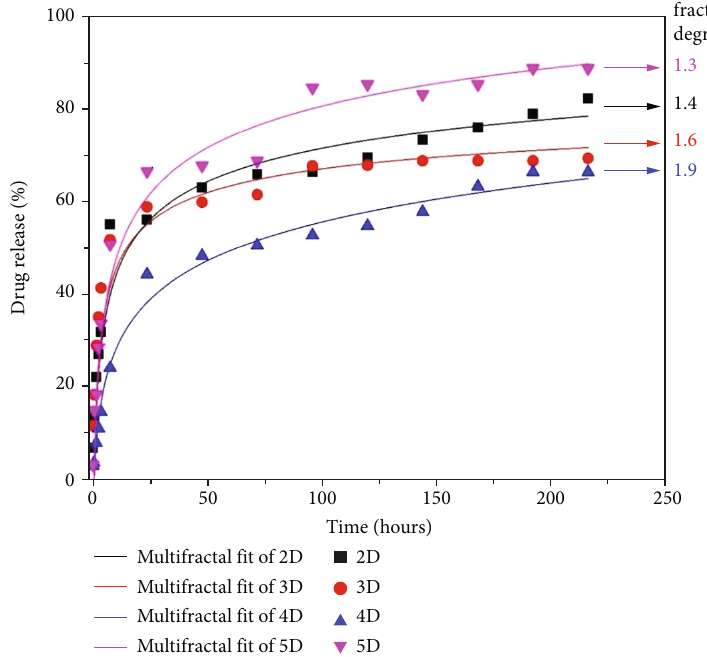
Figure 5: Experimental showcase of the DCF release from formulations fi tted by the multifractal theoretical